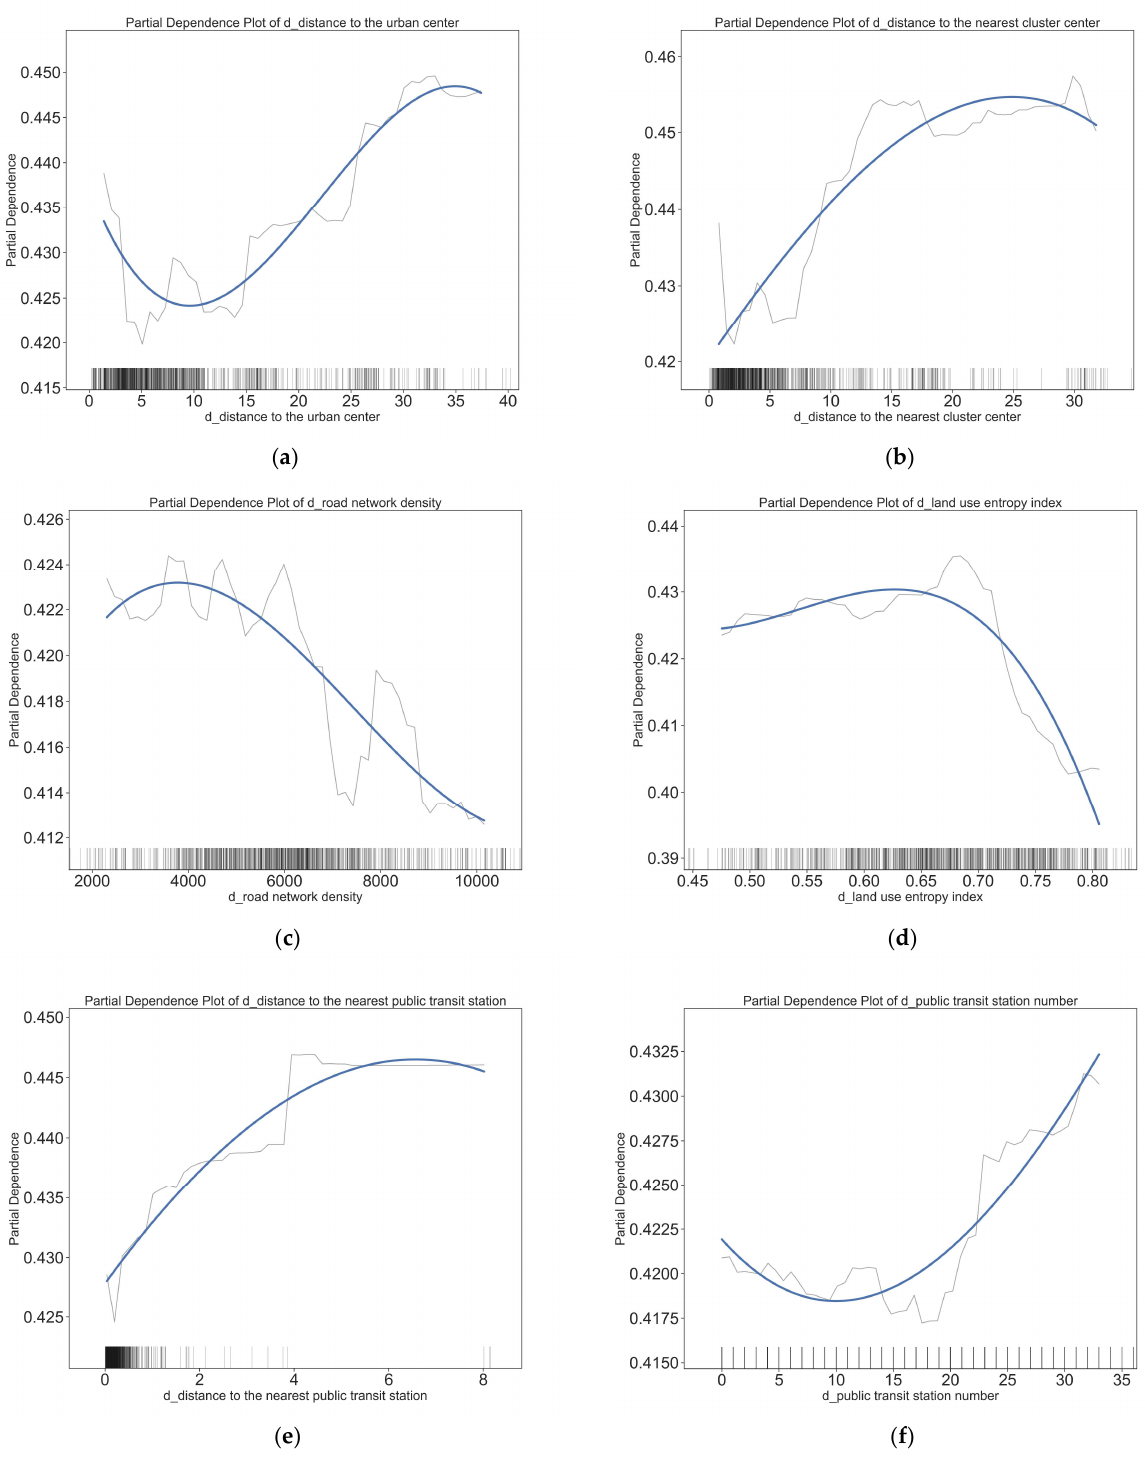
Figure 6. The effects of workplace-built (D points) environment variables on the choice to walk. ( a ) Impact of distance to the urban center on walking choices; ( b ) impact of distance to the nearest cluster center on walking choices; ( c ) impact of road network density on walking choices; ( d ) impact of land use entropy index on walking choices; ( e ) impact of distance to the nearest public transit station on walking choices; ( f ) impact of public transit station number on walking choices.